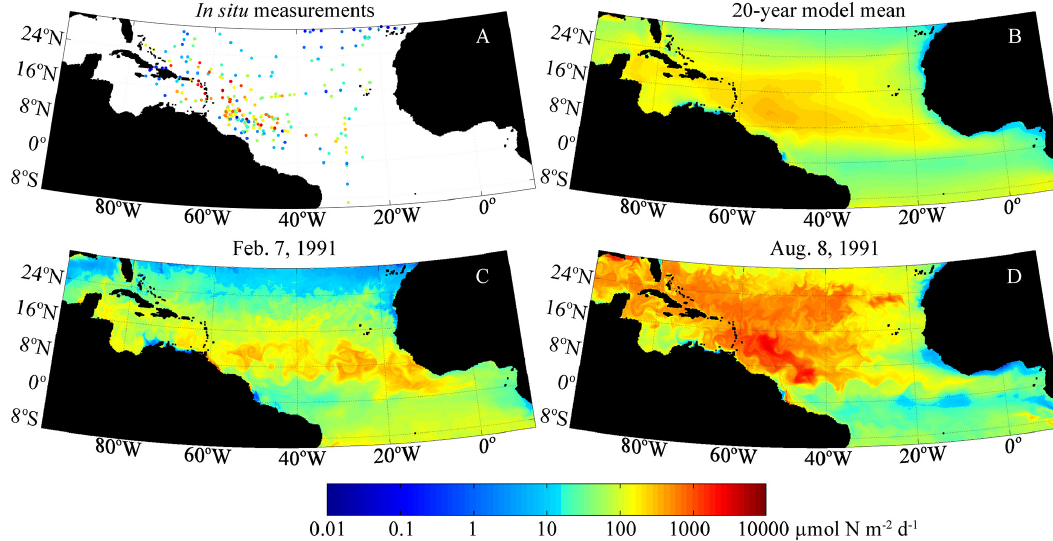
Figure 2. Basin-scale nitrogen fixation. Panel A shows in situ nitrogen fixation measurements compiled by Luo et al. (2012) on a logarithmic scale. Panels (B) , (C) , and (D) show model values from our DIAZO base model run representing the 20-year model mean (B) , and single day values from 7 February 1991 (C) and 8 August 1991 (D) . These days were chosen because they showed the lowest and highest, respectively, rates of nitrogen fixation during the “normal” year of 1991 and hence highlight the seasonal variability in the